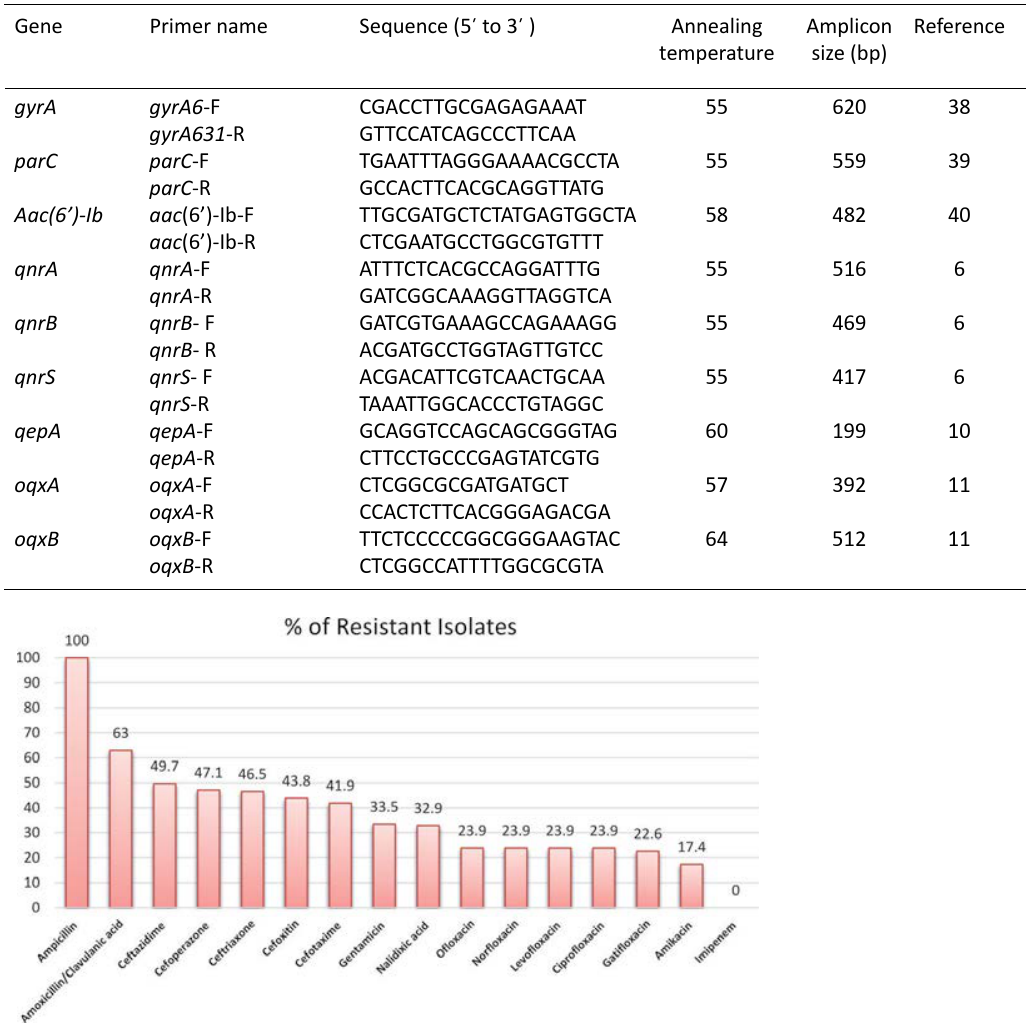
Table 1. Oligonucleotide primers used for PCR amplification and sequencing of resistance genes